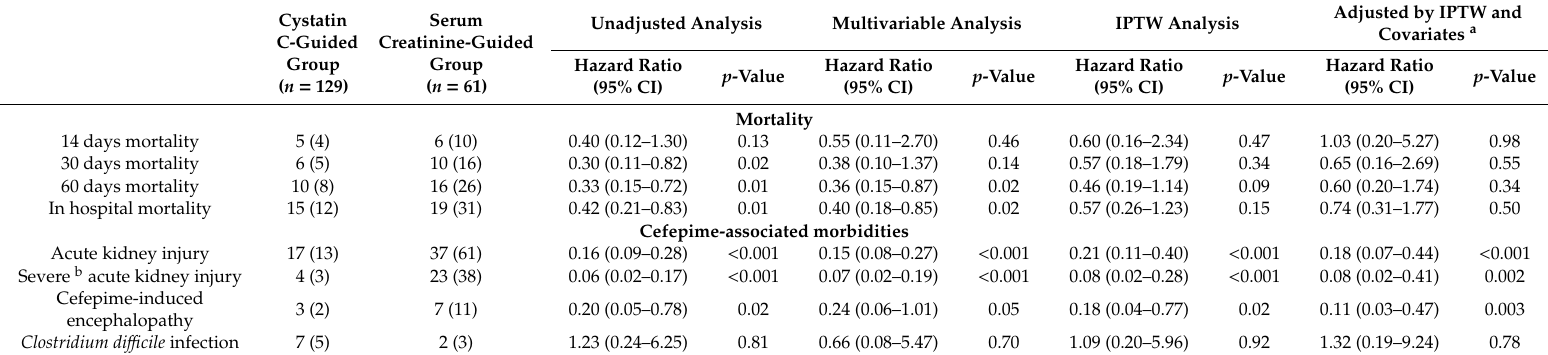
Table 2. E ffi cacy and safety of cystatin C-guided renal dose adjustment of cefepime in hospitalized patients with pneumonia. Cystatin Serum Unadjusted Analysis Multivariable Analysis IPTW C-Guided Creatinine-Guided Group ( n = 129)